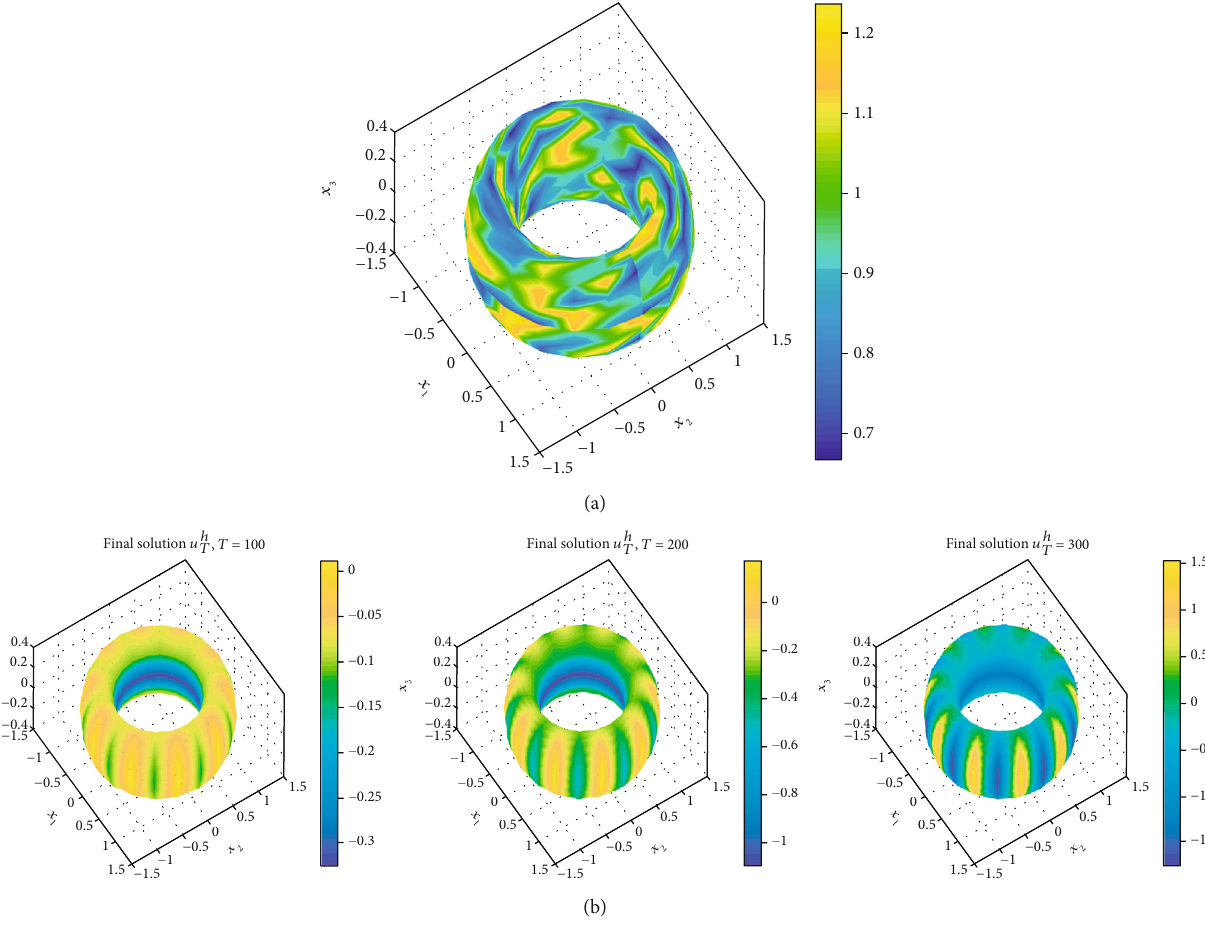
= 2 : 322 × 10 − 3 ; D = 0 : 0045 ; T = 100, 200, 300 ; R = 1 ; v